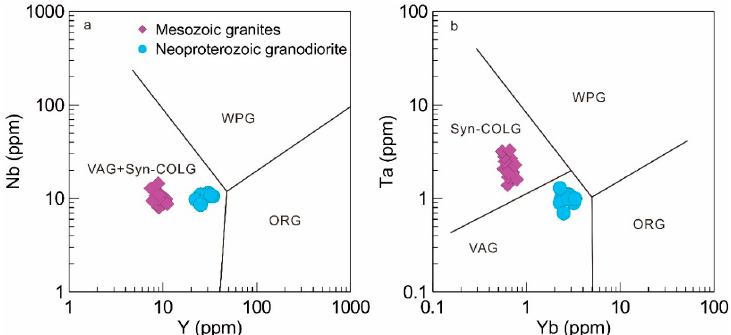
Figure 14. ( a ) Nb vs. Y; ( b ) Ta vs. Yb tectonic discrimination diagrams (after Pearce et al. [52]) for the Shimensi granodiorite. VAG, volcanic arc granite; ORG, ocean ridge granite; WPG, within plate granite; syn-COLG and post-COLG, syn- and post-collision granite; COLG, collision granite. Data of the ore-related Mesozoic Shimensi granites are from Wei et al. [6].